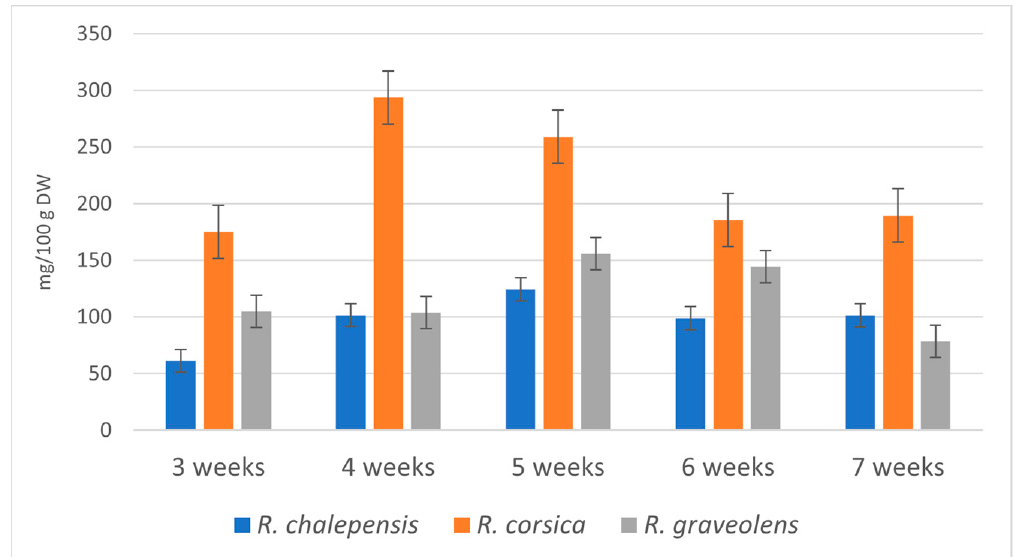
Figure 3. Total content of alkaloids (mg/100 g DW) in the methanol extracts obtained from the Ruta spp. in vitro cultured biomass in the consecutive weeks of the breeding cycle. Values are expressed as the mean ± SD ( n = 3).